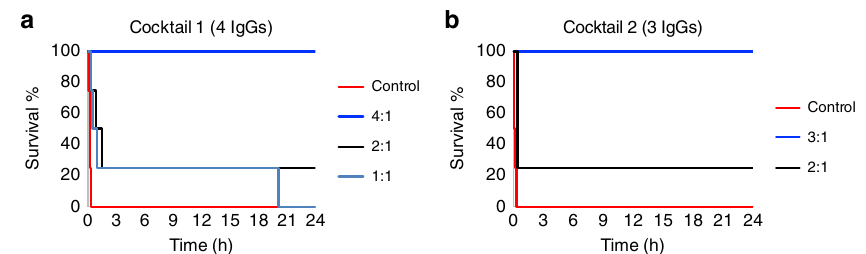
Fig. 4 Kaplan-Meier survival curves for antibody cocktails. Here, shown for a Cocktail 1 and b Cocktail 2 at different molar ratios against black mamba whole venom administered i.c.v., demonstrating full protection at an IgG:toxin molar ratio of 4:1 for Cocktail 1 and 3:1 for Cocktail 2. Cocktail 1 contains the IgGs: 361_01_F07 (anti-Dp5), 363_01_F07 (anti-Dp6), 365_01_G06 (anti-Dp7), 367_01_H01 (anti-Dp8). Cocktail 2 contains the IgGs: 363_01_F07